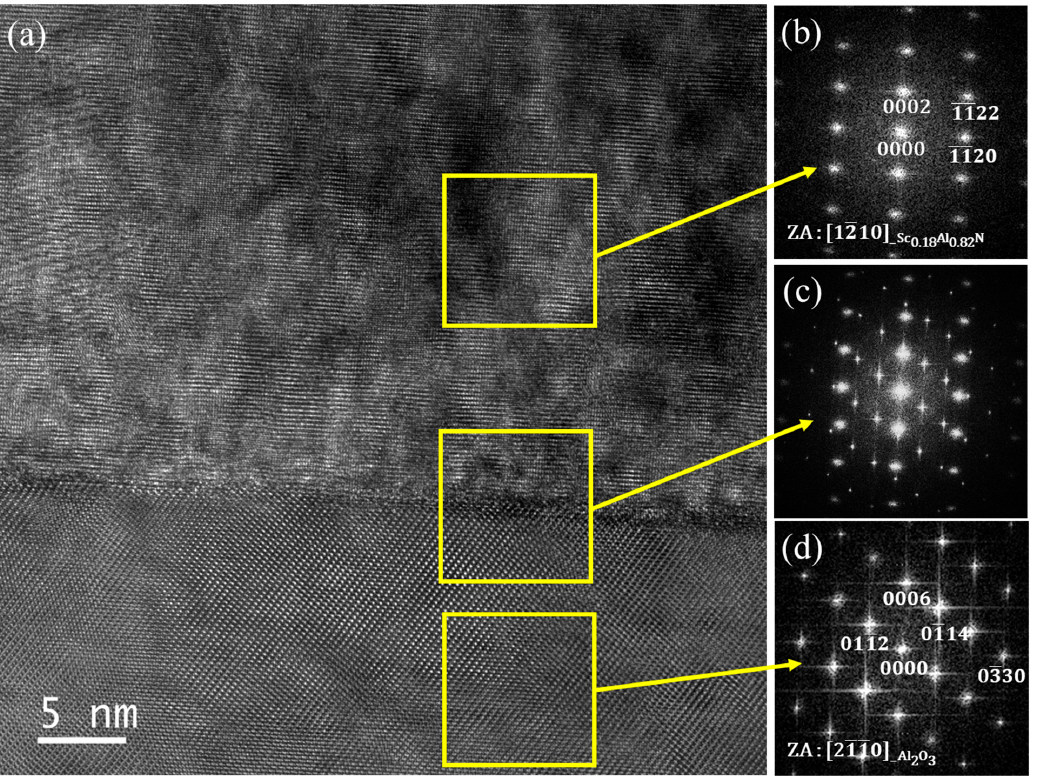
Figure 7. HRTEM micrograph made on the Sc 0.18 Al 0.82 N/sapphire structure ( a ) and corresponding FFT of the Sc 0.18 Al 0.82 N thin film ( b ), film/substrate interface ( c ) and the sapphire substrate ( d ).